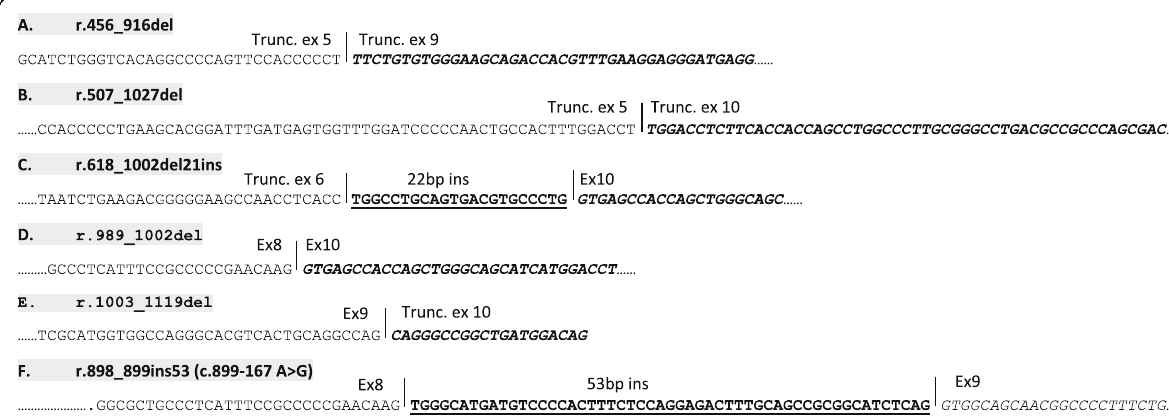
Fig. 2 Aberrant splicing products detected in Morquio A patients in the heterozygous state. The alternative GALNS cDNA (RT-PCR) products were detected in samples from: a Pt3; b , c Mother of Pt3; d Pt3 and his father; e Pt2; f Pt1. Ten normal controls were included alongside the three patients in the mRNA analyses in order to compare the GALNS cDNA amplification products. The control group did not show any aberrant transcripts. Del, deletion; ins, insertion; trunc, truncated; ex, exon